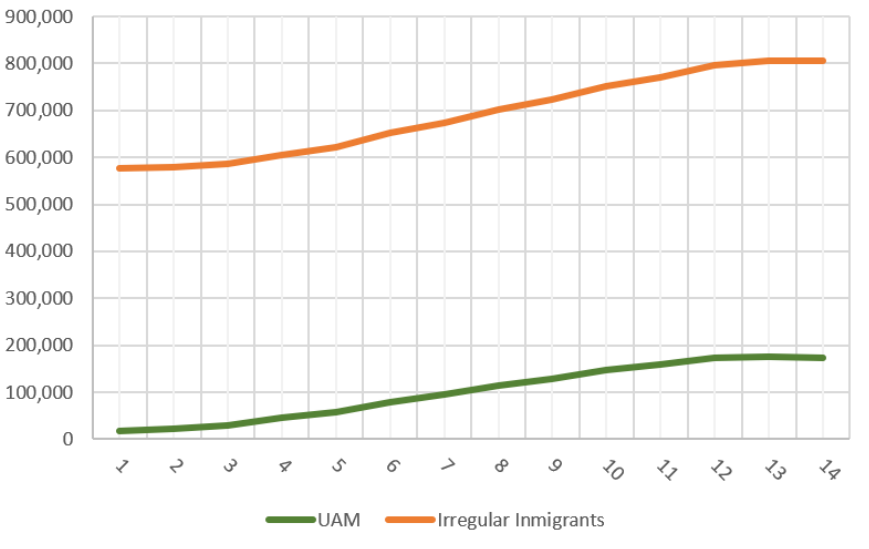
Figure 4. Population